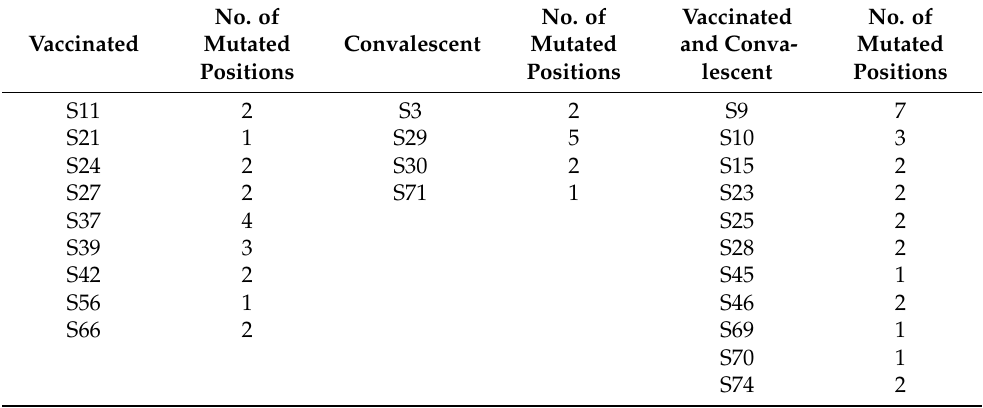
Table 3. Mutation analysis in SARS-CoV-2 S protein peptides recognized by vaccinated and COVID- 19 convalescent